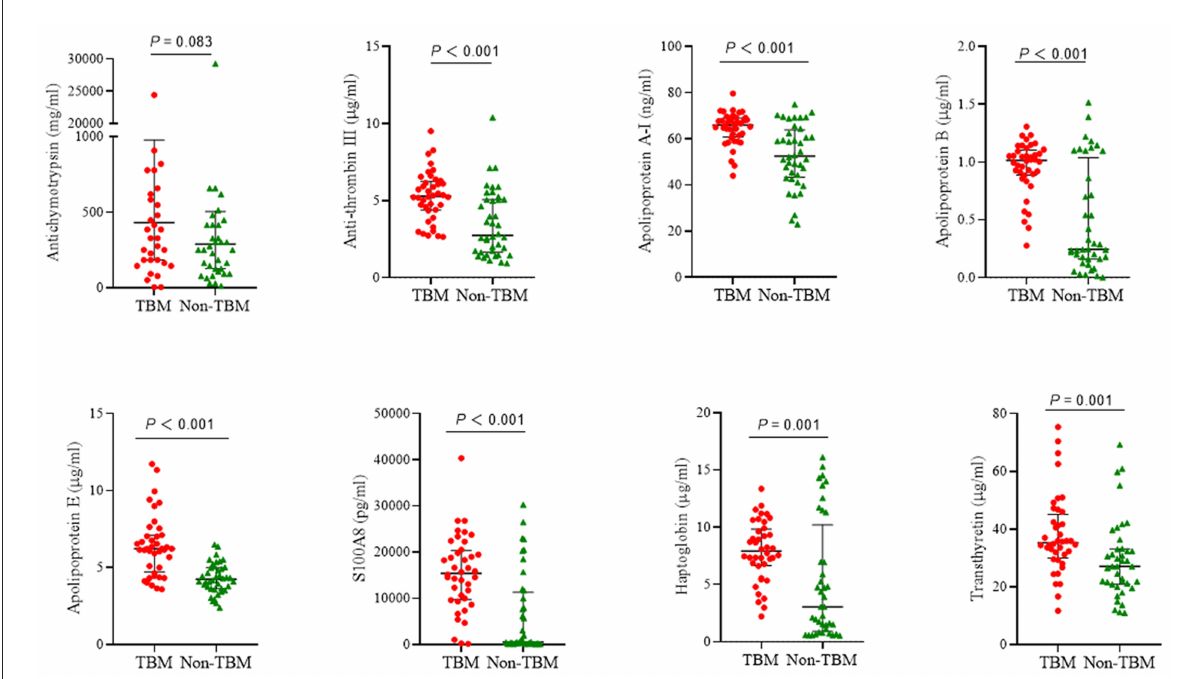
FIGURE2 The expression of 8 proteins in the cerebrospinal fluid between patients with TBM and non-TBM. TBM, tuberculous meningitis.